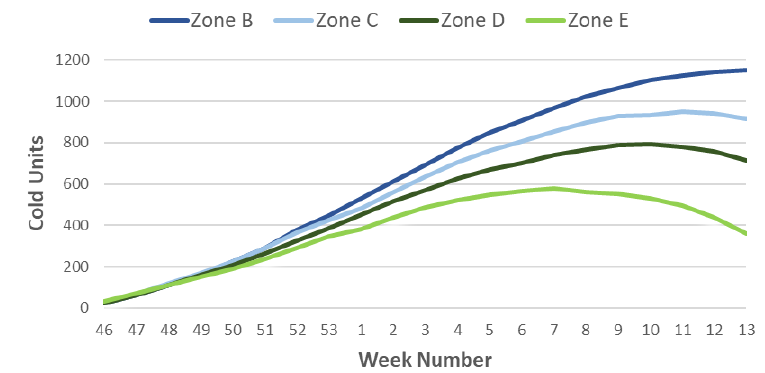
Figure 9. Representation of the Cold Units in the most representative weeks for the climatic zones of the Murcia Region.